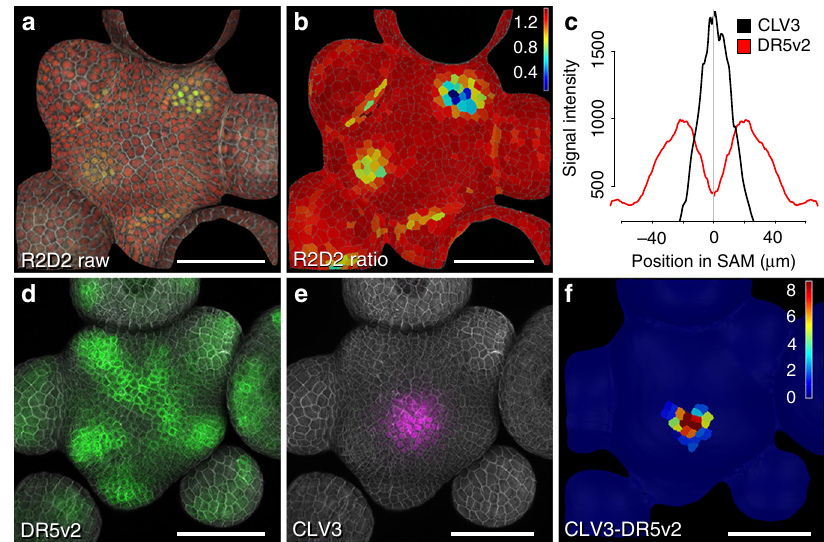
Fig. 1 Auxin output minimum correlates with apical stem cells. a Confocal readout from R2D2 auxin input sensor. b Ratiometric representation of R2D2 activity in the epidermal cell layer (L1). c Quanti fi cation of averaged pDR5v2:ER-eYFP-HDEL and pCLV3:mCherry-NLS distribution ( n = 5). d Confocal readout from pDR5v2:ER-eYFP-HDEL auxin output reporter. e pCLV3:mCherry-NLS stem cell marker in the same SAM. f Computational subtraction of L1 signals shown in d and e . Relative signal intensity is shown in arbitrary units. Scale bars: 50 µ